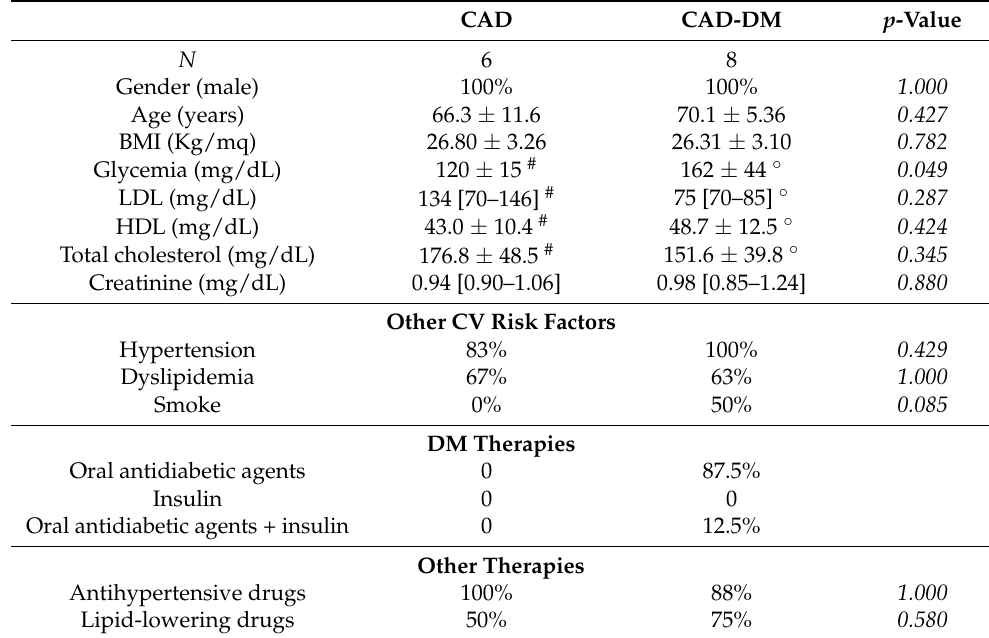
Table 2. Clinical profile, CV risk factors, and therapies characterizing the subgroup of CAD patients selected for RNA sequencing. Patients have been categorized for the presence of DM as a